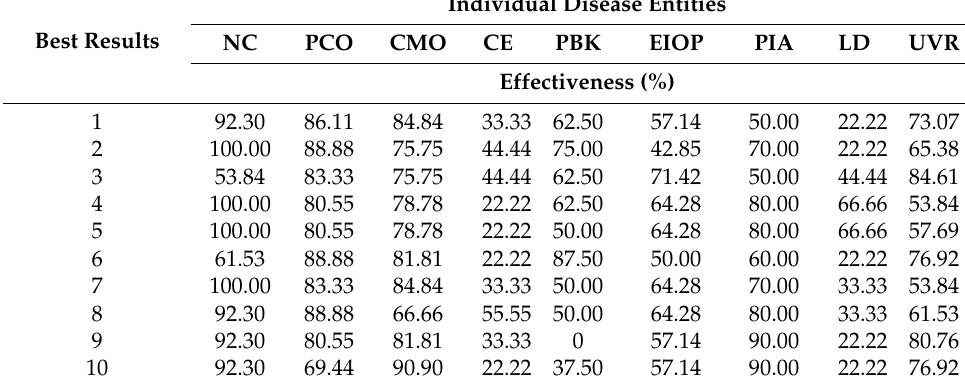
Table 5. The effectiveness of the classifier (decision trees) for the 10 best configurations of features broken down into individual complication entities “1”–“8” and patients without complications “0”. The entities are the following: no complications (NC), posterior capsular opacification (PCO), clinical macular oedema (CMO), long lasting corneal oedema solved without surgery (CE), pseudo-phakic bullous keratopathy (PBK), transient elevated intraocular pressure (EIOP), partial iris atrophy (PIA) intraocular lens decentration and/or dislocation (LD) and unsatisfactory visual recovery after cataract surgery (UVR). Individual Disease Entities Best Results NC PCO